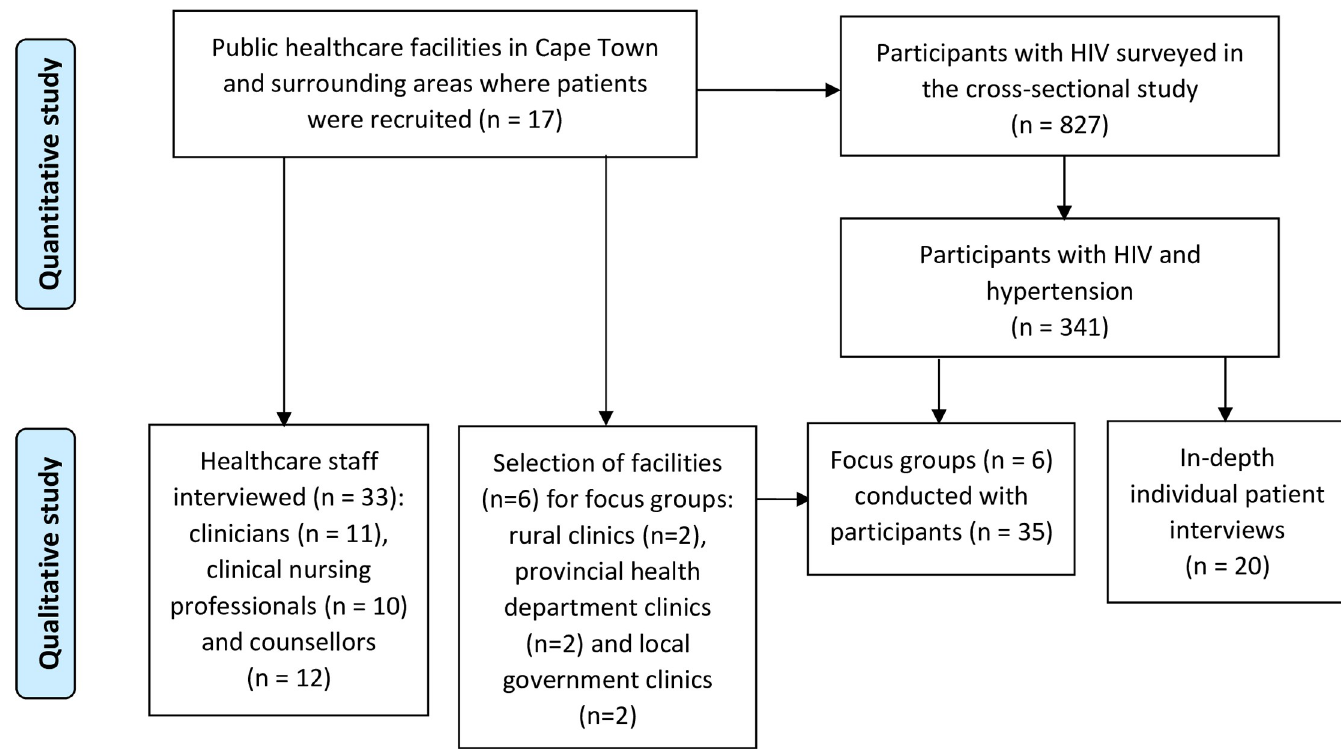
Fig 1. Sampling of study